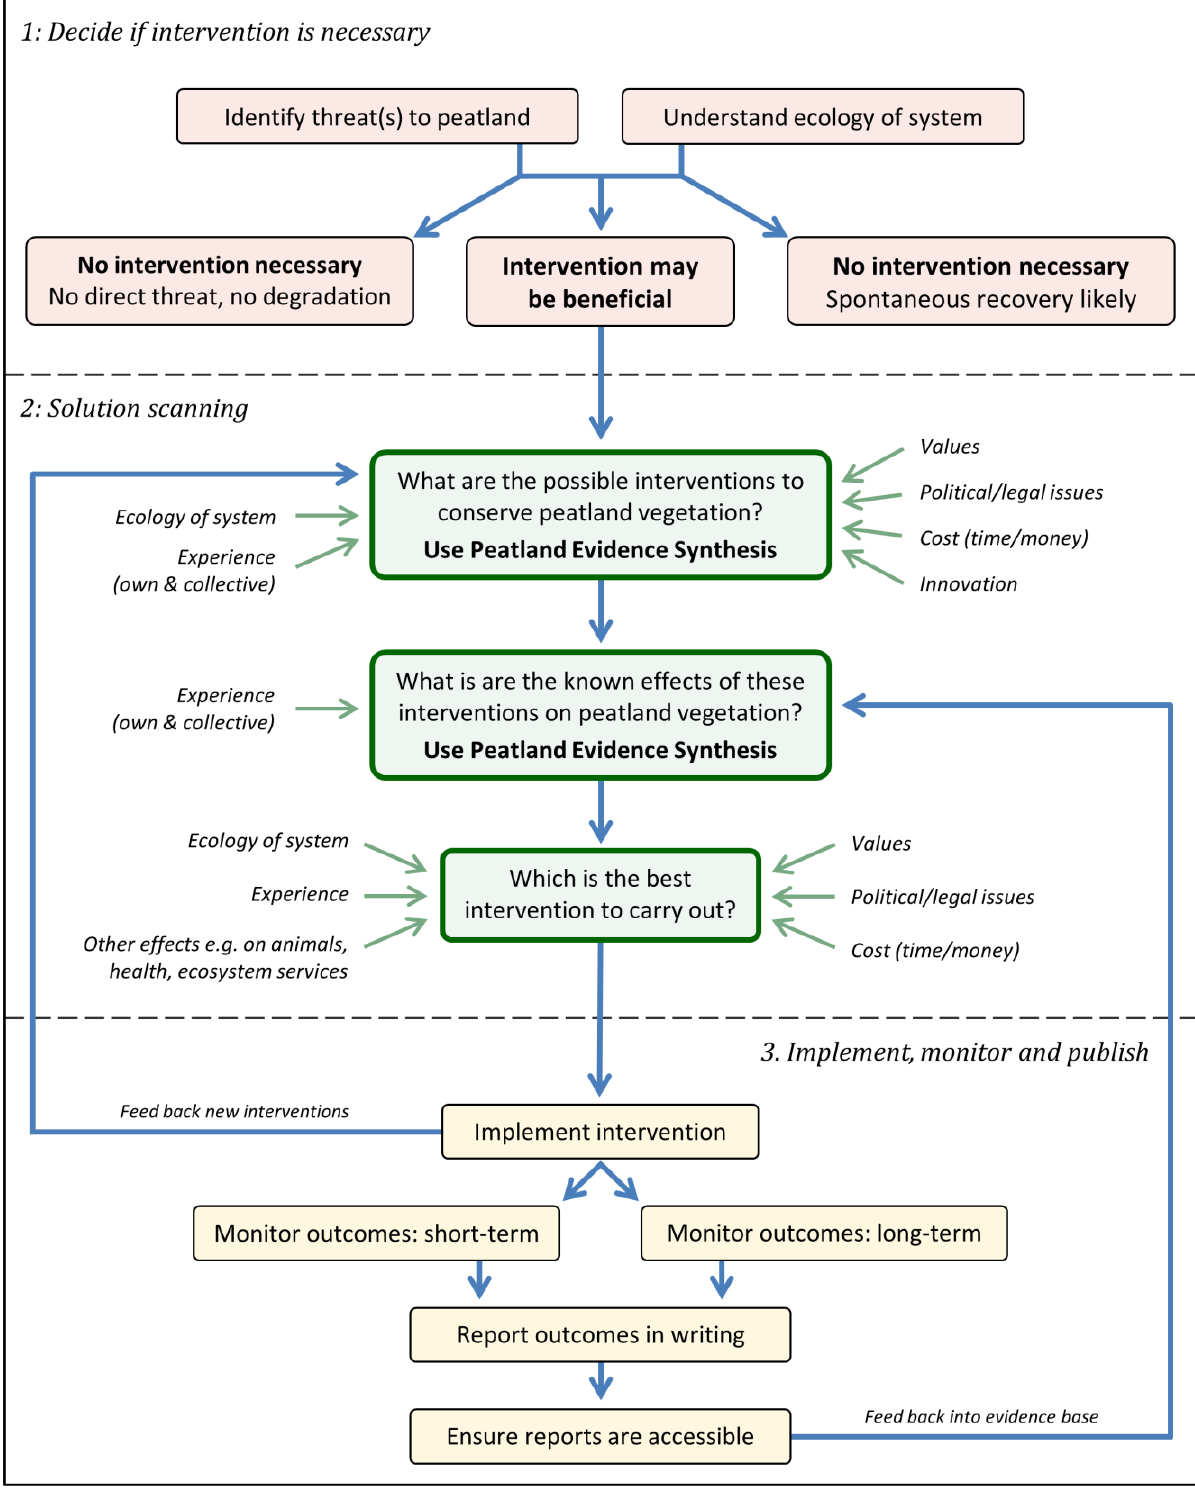
Figure 6. Possible decision making process for the conservation of peatland vegetation, indicating where the Peatland Evidence Synthesis can contribute (green